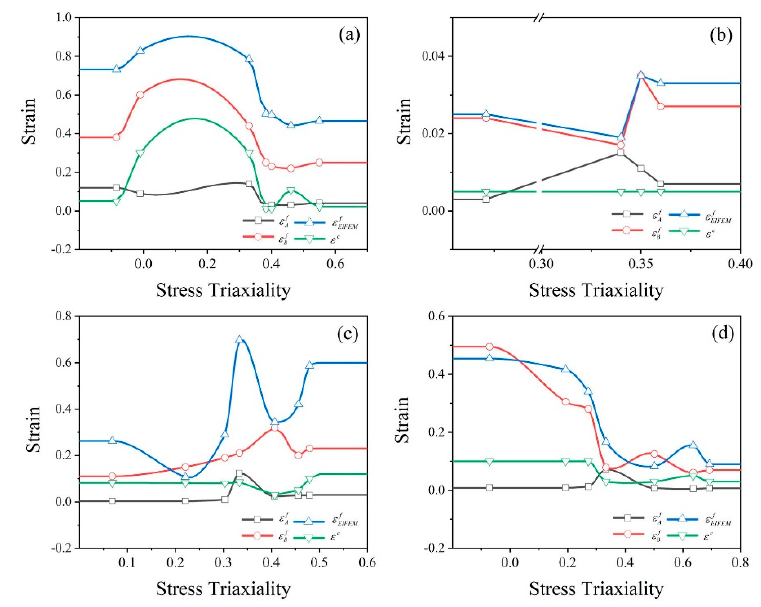
Figure 10. Strain and triaxiality curves for ( a ) 7003 aluminum alloy, ( b ) ADC12 aluminum alloy, ( c ) ZK60 magnesium alloy and ( d ) 20CrMnTiH steel.